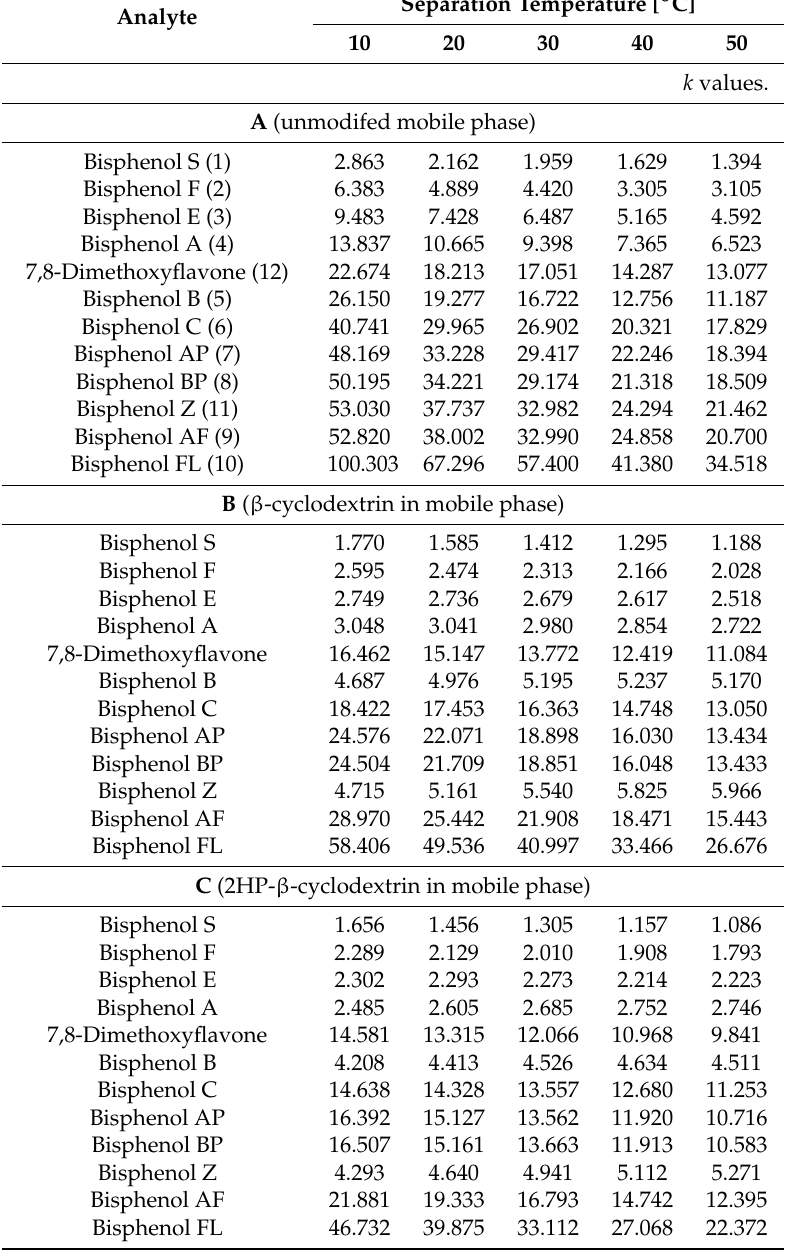
Table 1. Values of chromatographic retention factor ( k ) of analytes separated on a 10 cm long LC-18 column at various temperatures and using mobile acetonitrile/water (35%, v / v ) unmodified ( A ) and modified phases β -cyclodextrin ( B ) and its hydroxypropyl derivative ( C ) at a concentration of 10 mM. The substance numbers correspond to the order of the analytes given in the Figure S1; Supporting